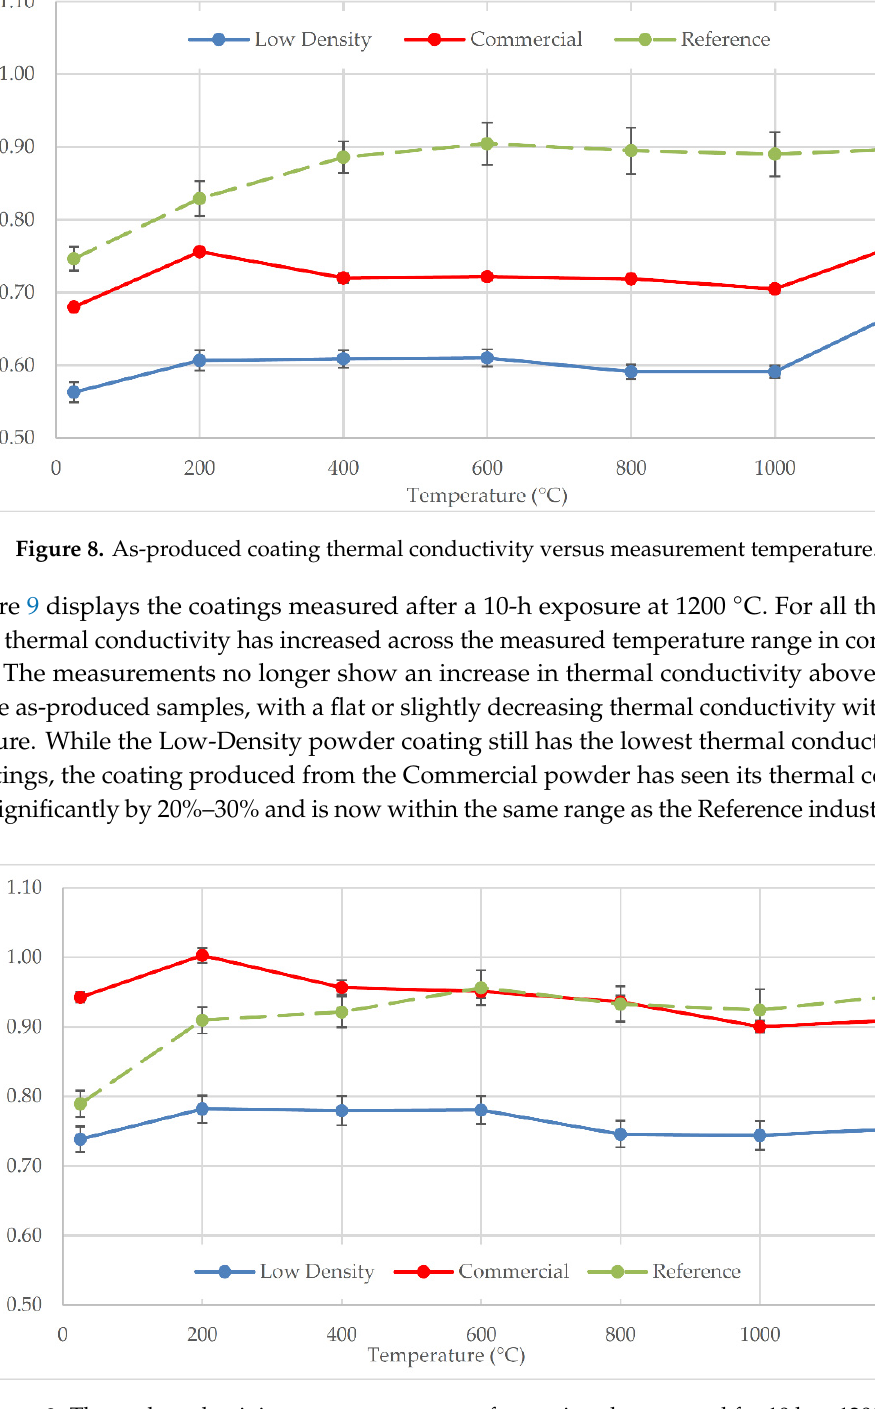
Figure 9. Thermal conductivity versus temperature for coatings heat treated for 10 h at 1200 °C.